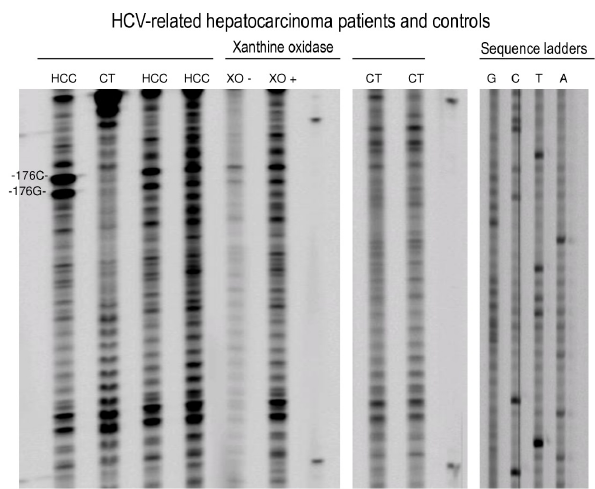
Figure 1. Sequencing gels showing the intensities of oxidative adduct-induced formamidopyrimidine DNA glycosylase (Fpg) and endonuclease III (EndoIII) incisions at the codon 176 along the exon 5 sequence of the p53 gene of hepatitis C virus (HCV)-associated hepatocellular carcinoma (HCC) patients and controls (Lanes 1–4, 8, and 9 from the left side), as well as human hepatocytes treated with 0.2mM xanthine plus 5.0mU xanthine oxidase (XO)-treated (Lanes 5 and 6). Autoradiograms: Lanes: 1, 3 and 4, HCV-HCC patients; Lanes 2, 8, and 9, controls; Lane 5, XO treatment; Line 6, no XO treatment; Lanes 7 and 10 molecular weight; Lanes 11–14, sequencing ladders. Heavy modified –G– and –C– positions at codon 176 are